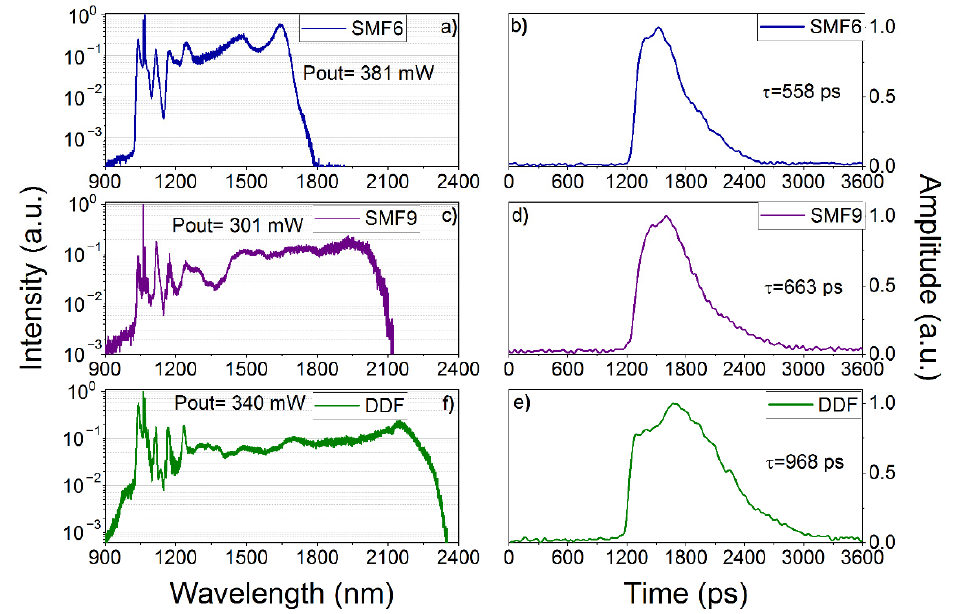
Figure 3. SC optical spectra ( a , c , f ) were obtained when using various NF samples and pulse envelopes at an input energy of 0.8 μ J ( b , d , e ).